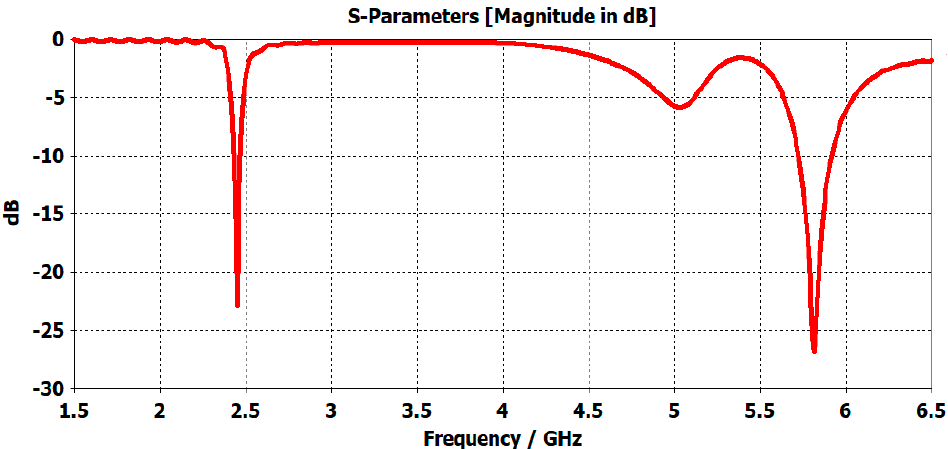
Figure 2. Reflection coefficient of the antenna. Table 1. Proposed antenna’s dimensions.